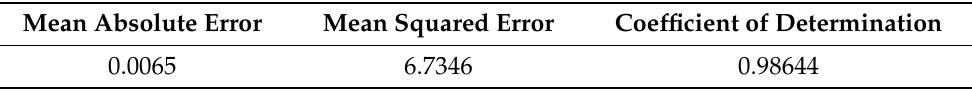
Table 3. Evaluation metrics of the linear regression